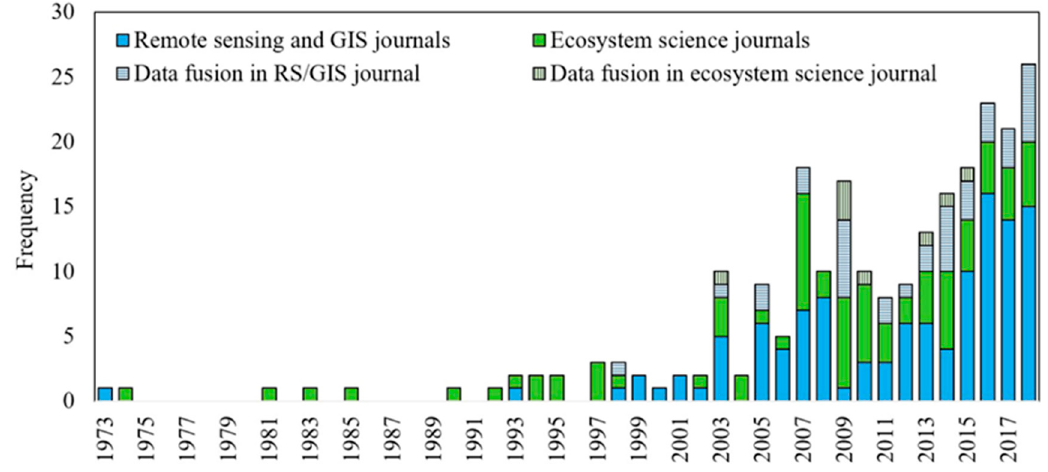
Figure 3. Frequency of articles published in peer-review journals that compared remotely sensed data with measured wetland attributes over time. Articles were categorised into either remote sensing (RS) and geographic information system (GIS) journals or in ecosystem science journals and the year of publication. Also included is the frequency of publication of multiple sensor-conflation methodologies within remote sensing and ecosystem science literature (n = 241 journal articles including accuracy statistics examined). As of the writing of this article, a total of 1701 articles published in English use remote sensing to examine global wetland characteristics (Web of Science).